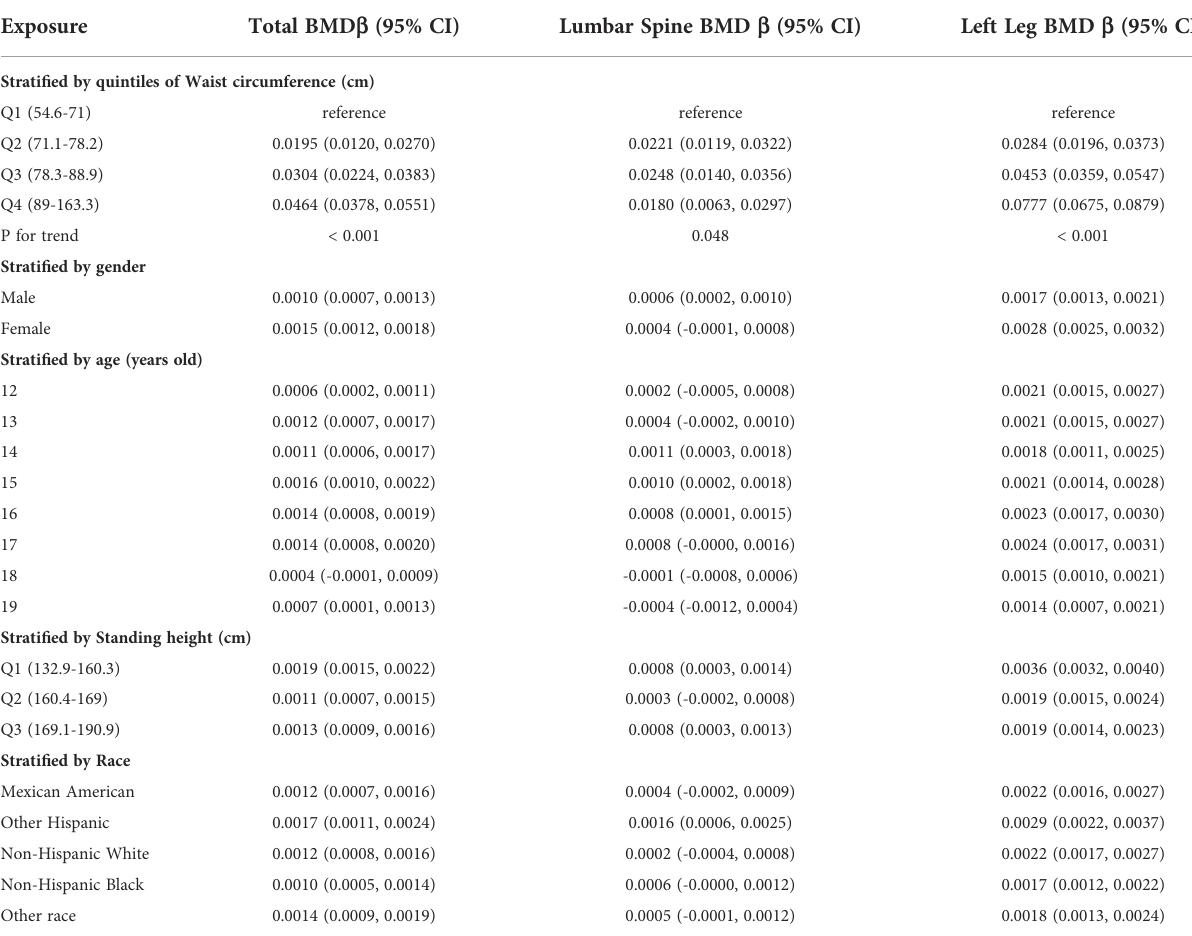
TABLE 4 Association between waist circumference (cm) and bone mineral density (g/cm 2 ).